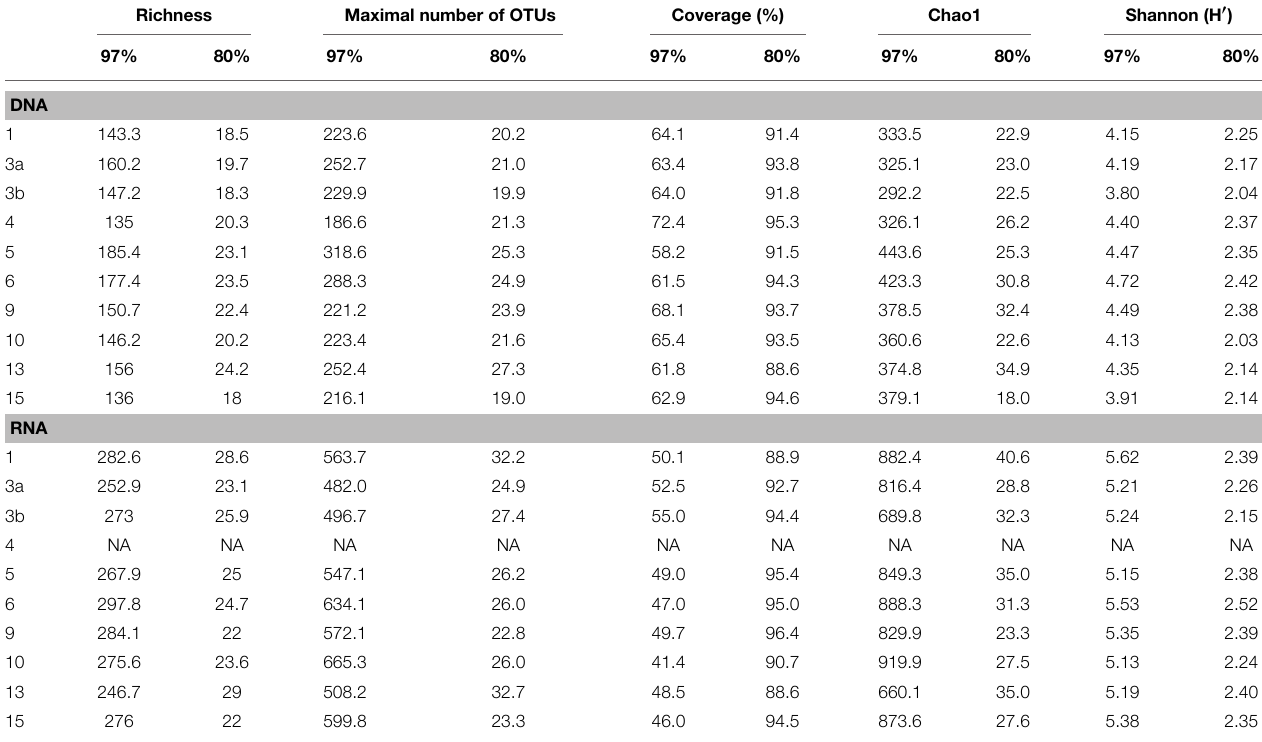
TABLE 7 | Alpha diversity indices at 97 and 80% genetic similarity derived from the 16S rRNA analysis. Richness Maximal number of OTUs Coverage (%) Chao1 Shannon (H ′ )